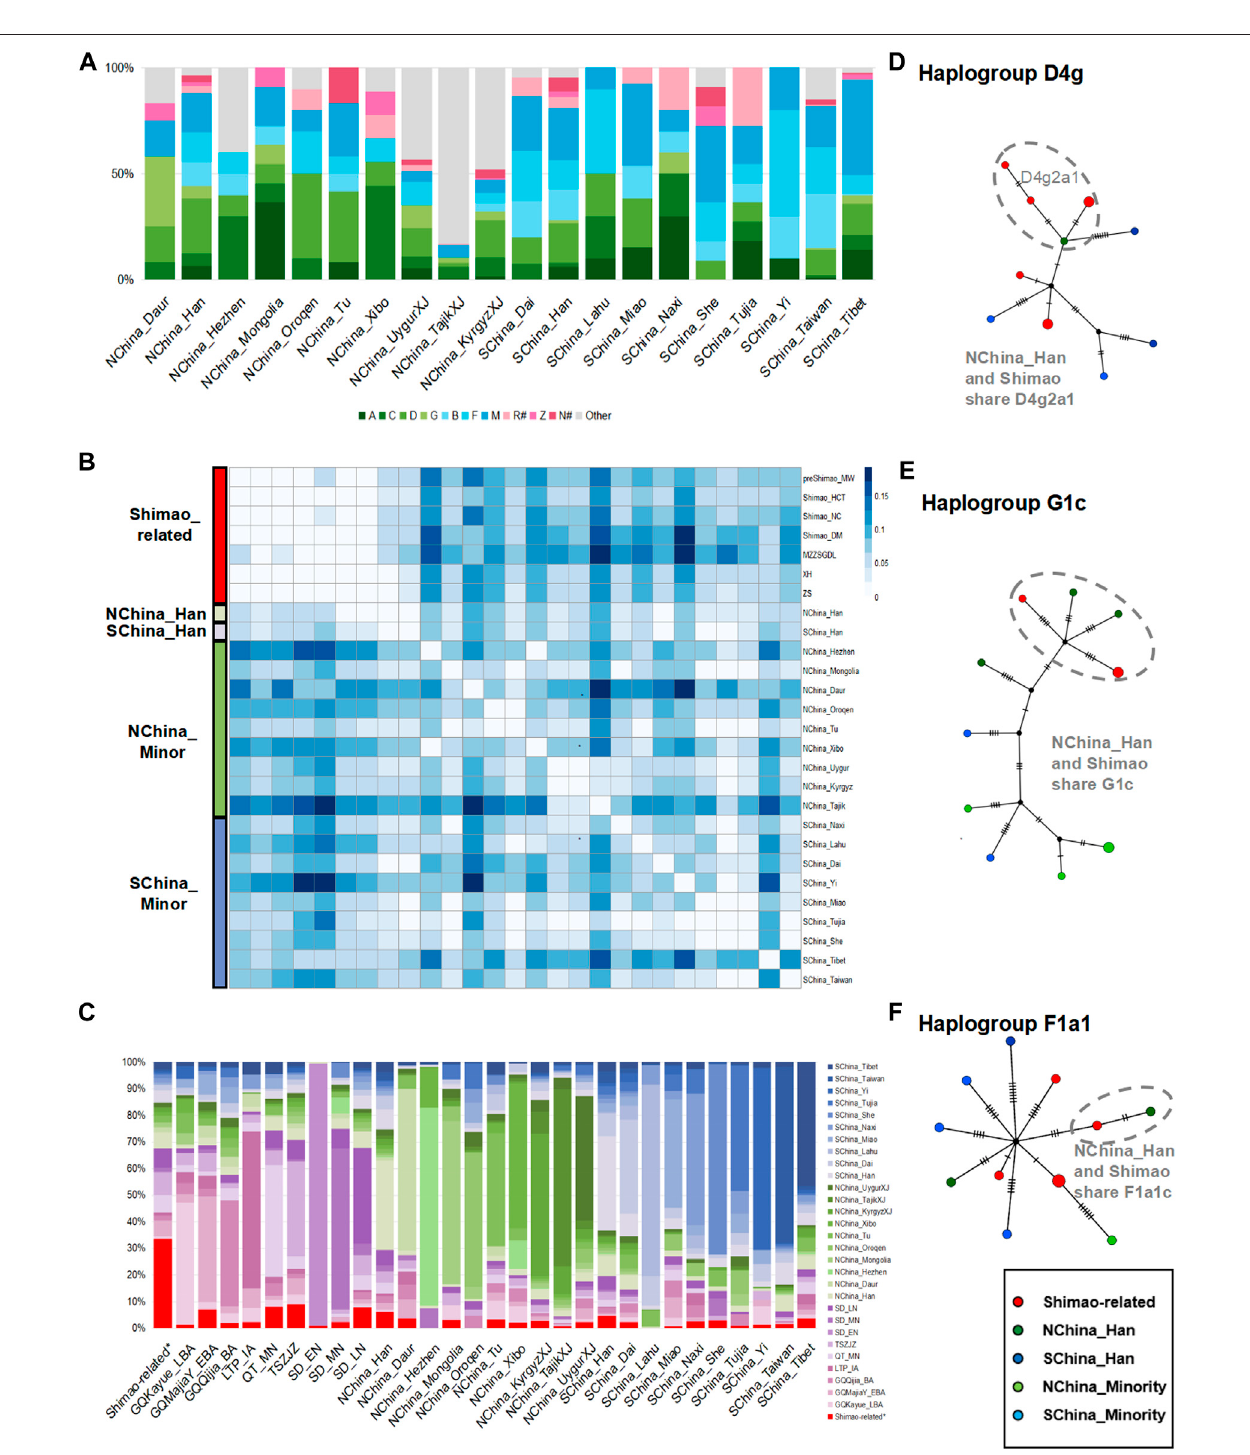
FIGURE 4 | The genetic analysis between Shimao-related populations and present-day Chinese populations. (A) Haplogroup frequencies. The haplogroups with green are those common in NEAs, and those with blue are common in SEAs. The haplogroups absent from Shimao-related populations are grouped in “ Other. ” The haplogroups R # and N # representthe haplotypes found inEast Eurasians (suchas haplotype R+16189, sub-haplogroups R11and N9, which were also observed in the Shimao-related populations). The other sub-haplogroups R and N found in West Eurasians were assigned to “ Other. ” (B) Genetic distance ( F ST ) heatmap of Shimao-related populations and present-day populations. NChina_Minor: the minorities in northern China; SChina_Minor: the minorities in southern China, SChina_Tibet:thepopulationsinTibet;SChina_Taiwan:thepopulationsinTaiwan. (C) Haplogroupsharinganalysis.Greenandblueareusedtorepresentpopulationsin northern and southern China. Purple represents the ancient populations in YR. Median-joining networks of haplotypes D4g2a1 (D) , G1c (E) , and F1a1c (F) shared between Shimao-related populations and northern Han populations. Different colors of groups correspond to the heatmap in Figure 4B.